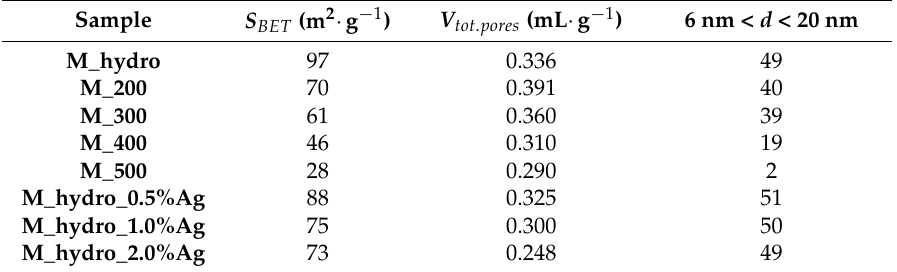
Table 1. Specific surface area ( S BET ), total pore volume ( V tot . pores ) and relative percentage of the pore size with a diameter ( d ) between 6 and 20 nm for hydrothermal, calcined and doped MnO 2 samples.